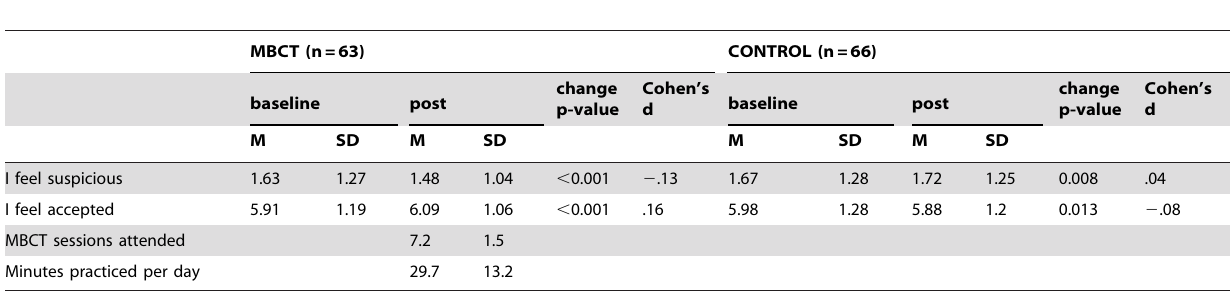
Table 2. Baseline and post-assessment means and standard deviations of experience sampling variables used in the analyses, stratified by group.